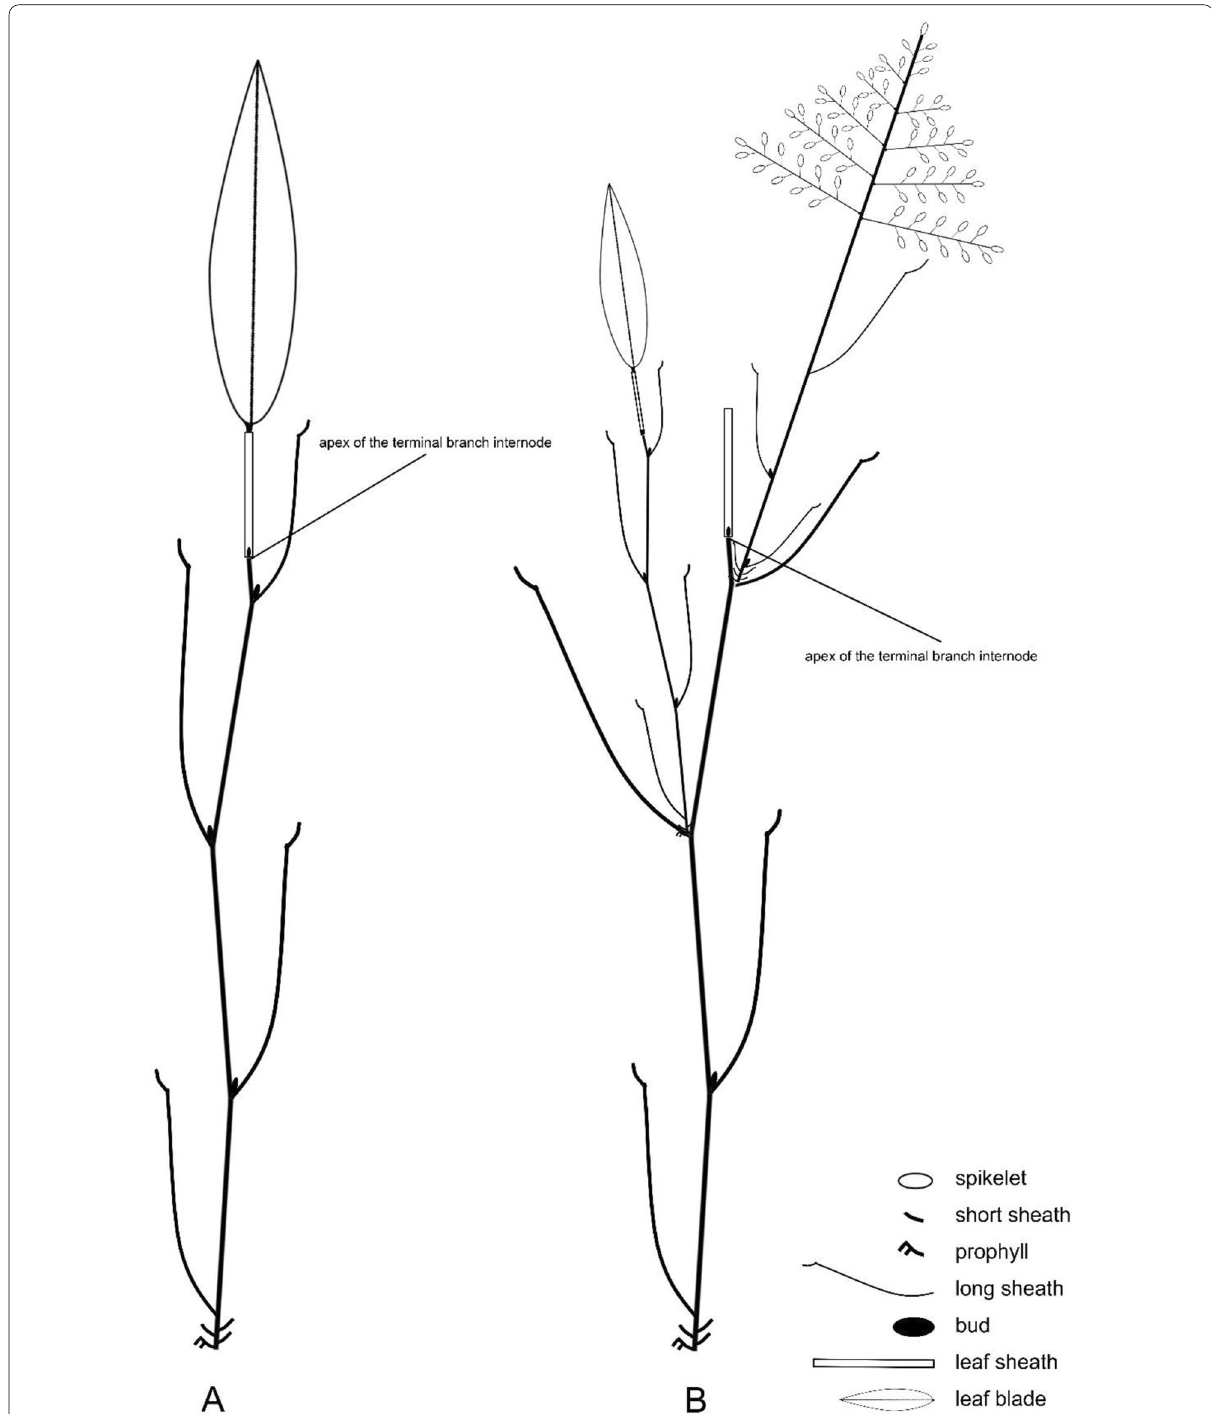
Fig. 3 Diagram of components of foliage branches of Gelidocalamus fengkaiensis N. H. Xia & Z. Y. Cai. A Earlier phase foliage branch with leaf blade; B later phase foliage branch whose leaf blade has fallen off and some buds at branch nodes have developed as new axes. However, the apical meristem of the primary branch internode does not develop